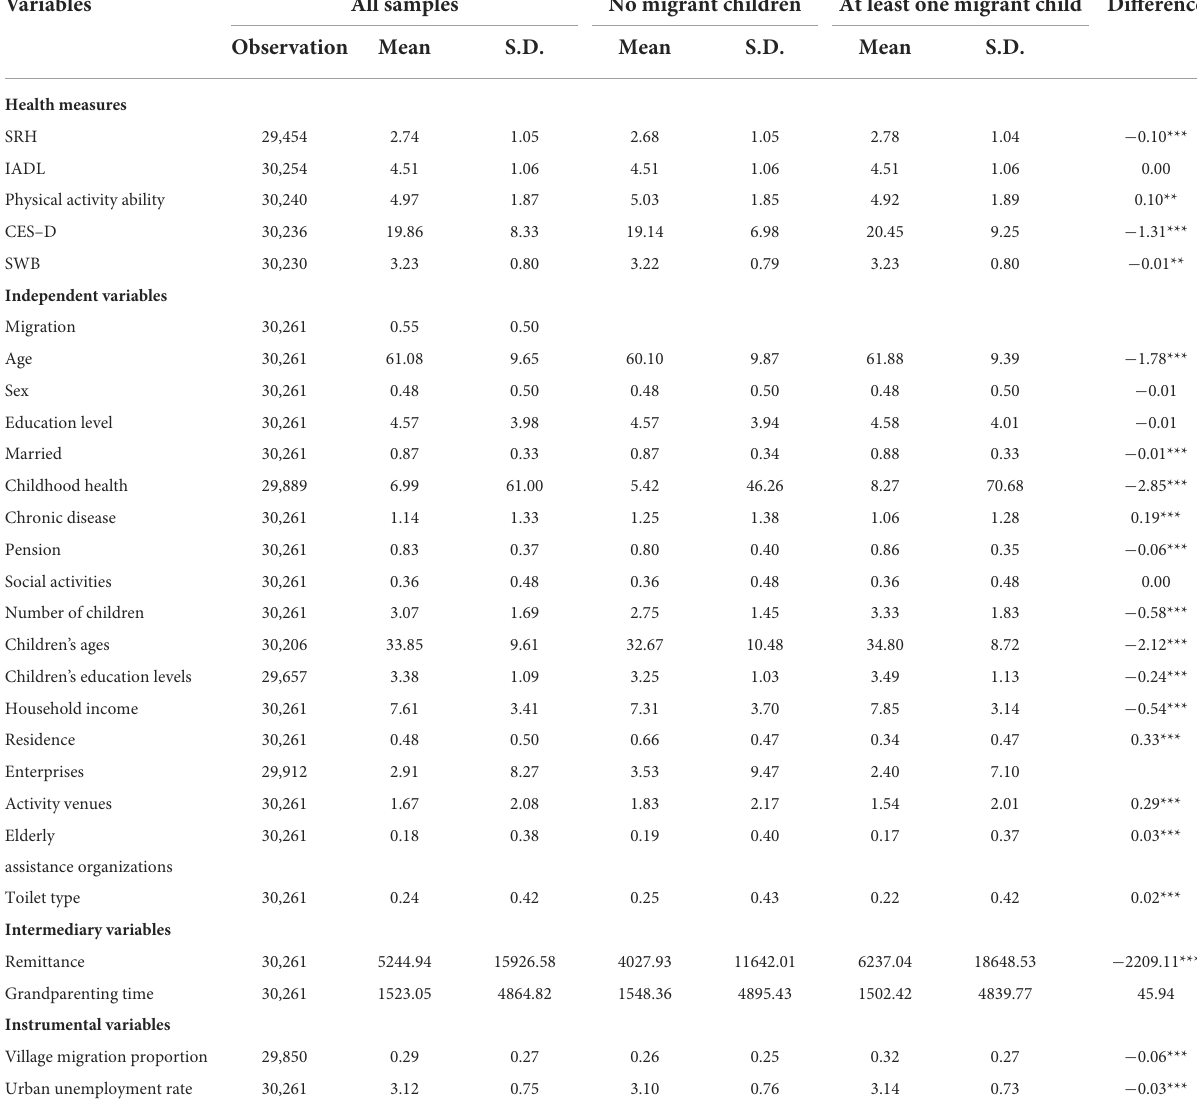
TABLE 2 Descriptive statistical analysis of the main variables.